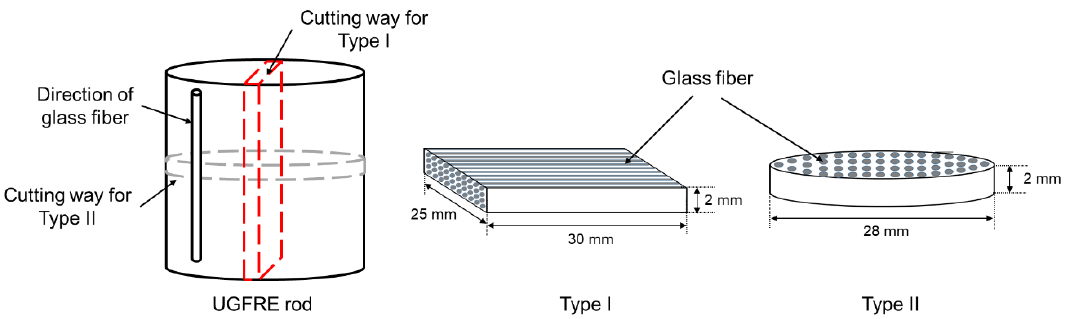
Figure 1. Obtaining methods and schematic diagrams of sample Type I and Type II.